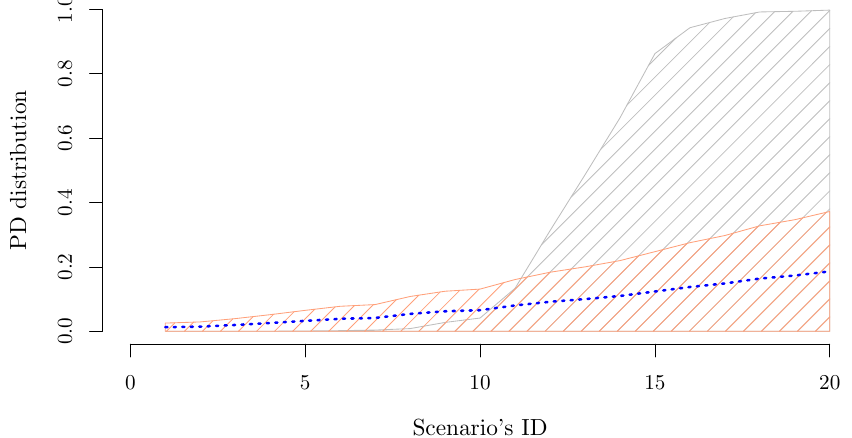
Figure 2. PD distribution across the considered scenarios. The blue dotted line plots the PD ex- pected value. The orange and grey areas represent the ± one standard deviation interval and the 0.5–99.5 percentiles interval,